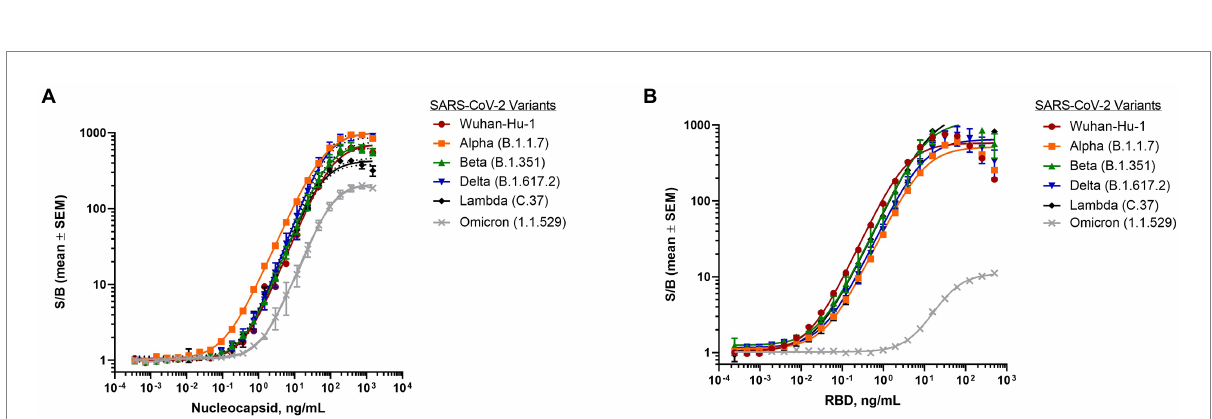
FIGURE 2 Detection of SARS-CoV-2 purified proteins from different variants. (A) Dose-response curve of purified nucleocapsid proteins from variants using nucleocapsid antigen assay. Final antibody concentrations were 30 ng/ml β 9-labeled anti-SARS-CoV-2 N mAb Cat. 9,547 and 60 ng/ml β 10-labeled anti-SARS-CoV-2 N mAb Cat. 9,548. (B) Dose-response curve of purified RBD proteins from variants using RBD antigen assay. Final antibody concentrations were 30 ng/ml β 9-labeled anti-SARS-CoV-2 spike RBD antibody D003 and 60 ng/ml β 10-labeled anti- SARS-CoV-2 spike RBD antibody D002. 1 μ M LgTrip was used in all experiments. Reagents were incubated for 90 min prior to the addition of Fz substrate. Luminescence was measured and the signal over background (S/B) was calculated for each concentration of purified viral protein. Shown are means ± SEM ( n = 3 independent